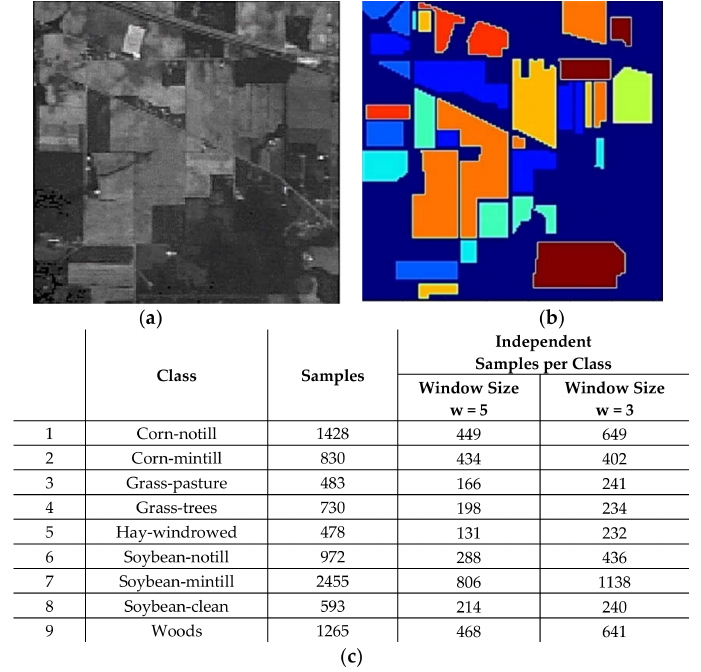
Figure 8. Hyperspectral remote sensing scenes from the Indian Pines dataset for the most representa- tive classes only: ( a ) sample band of the Indian Pines dataset, ( b ) reference map of the Indian Pines dataset, ( c ) reference map classes for the Indian Pines scene and their respective number of samples.